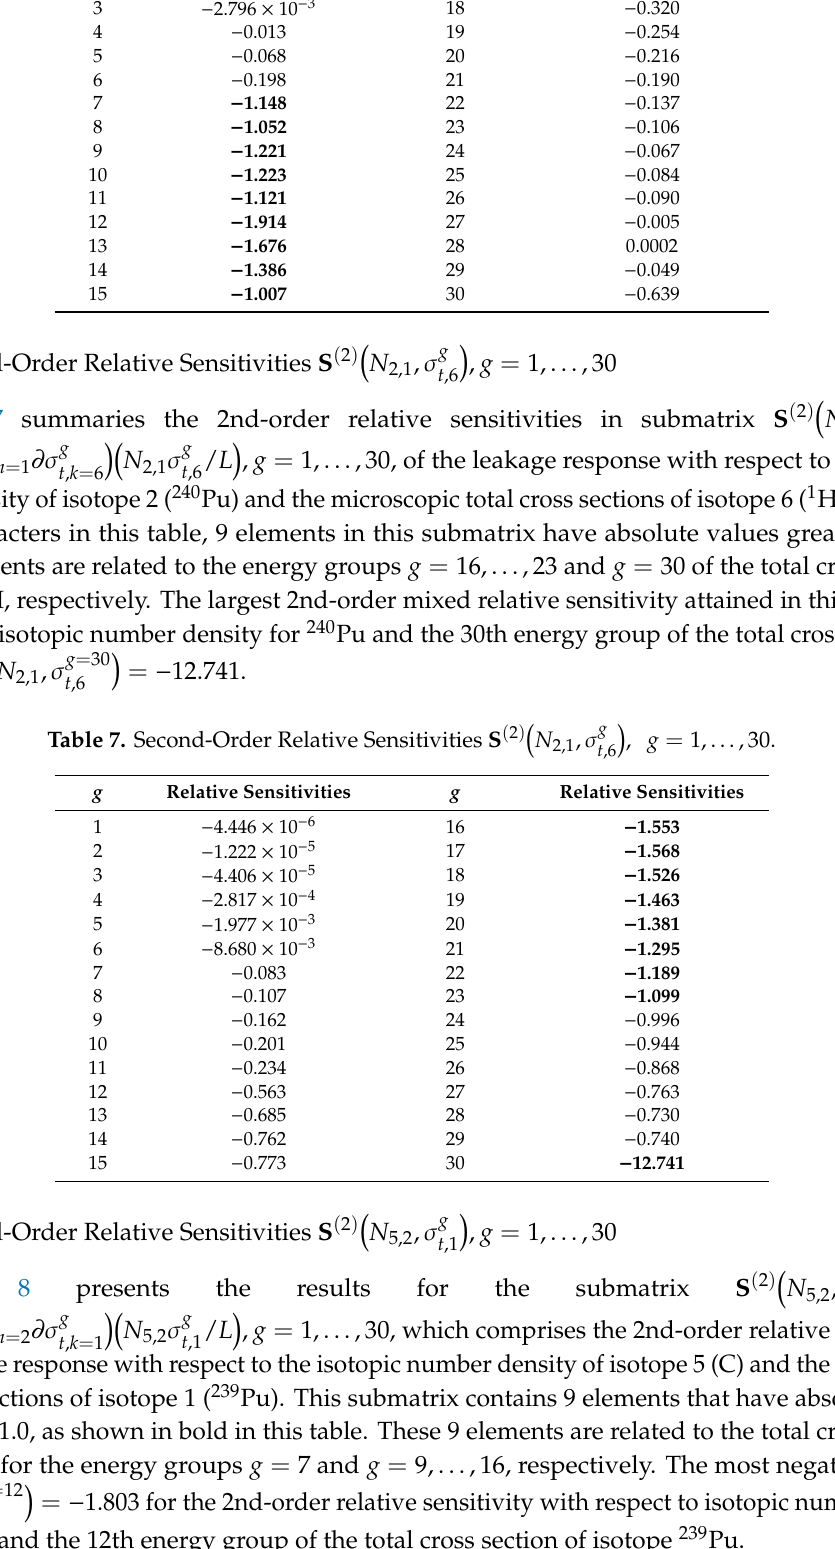
Table 6. Second-Order Relative Sensitivities S ( 2 ) g